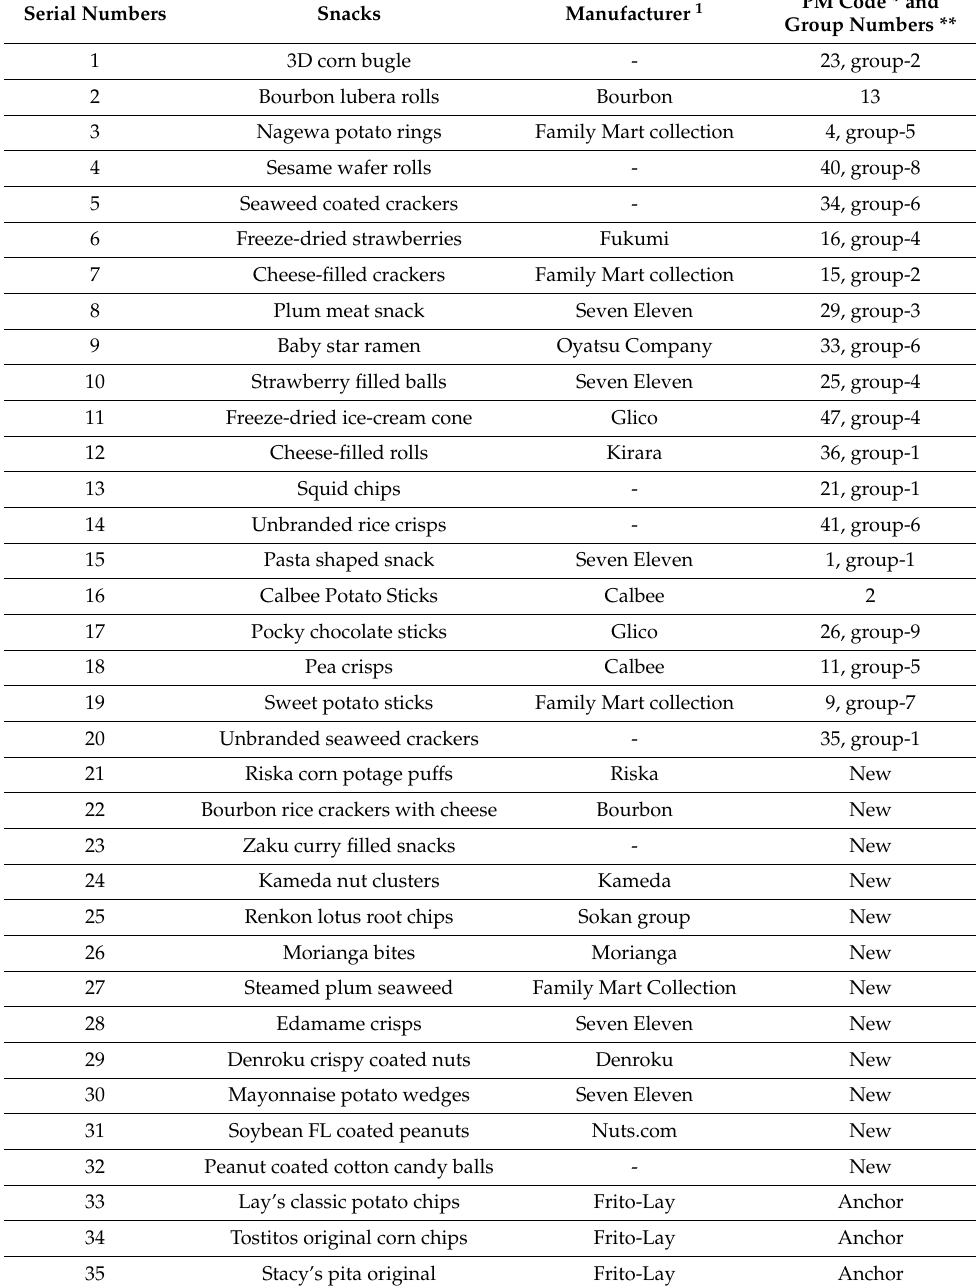
Table 1. List of the Japan (JP) snacks screened for descriptive